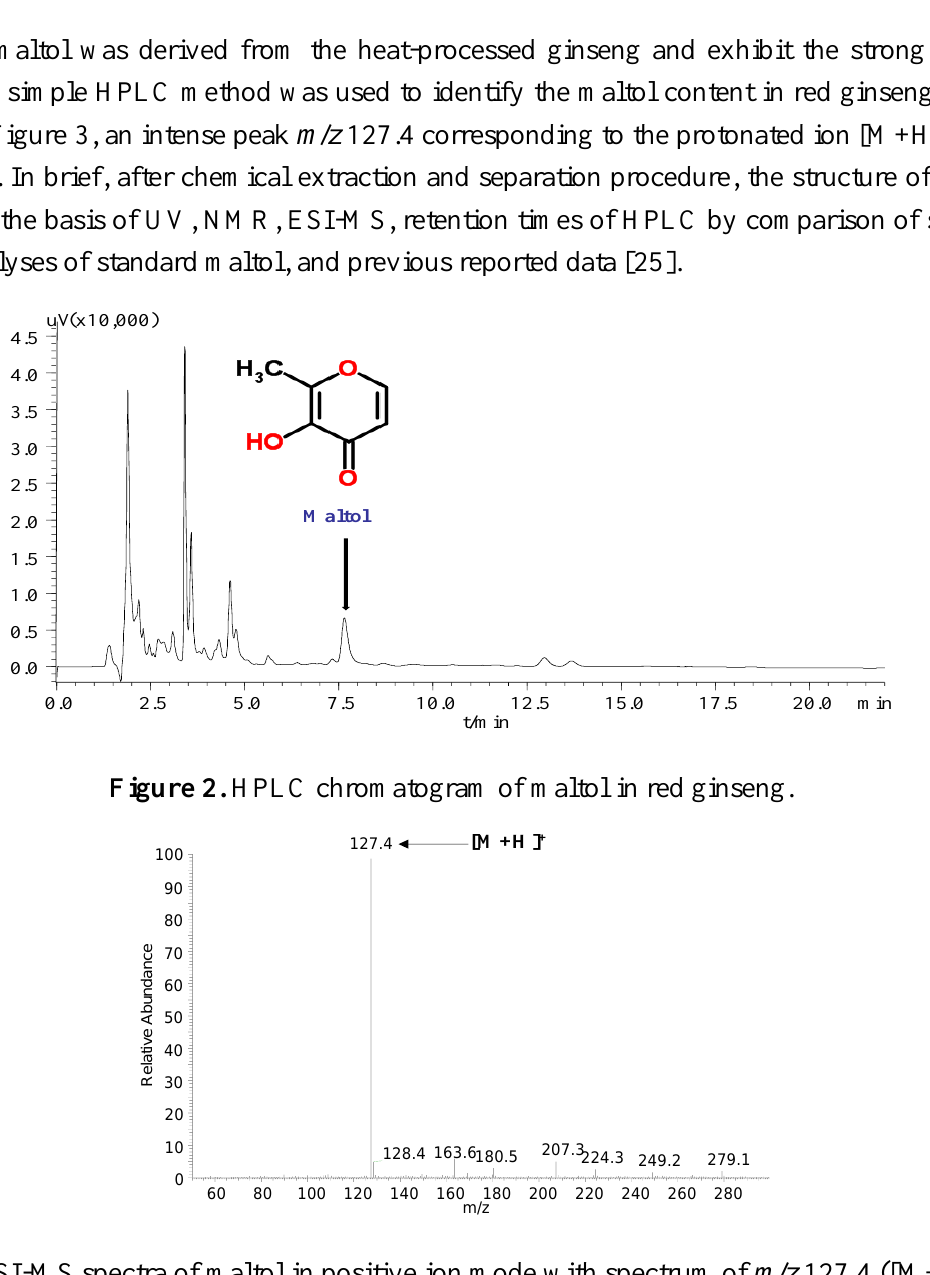
Figure 3. ESI-MS spectra of maltol in positive ion mode with spectrum of m / z 127.4 ([M+H] +